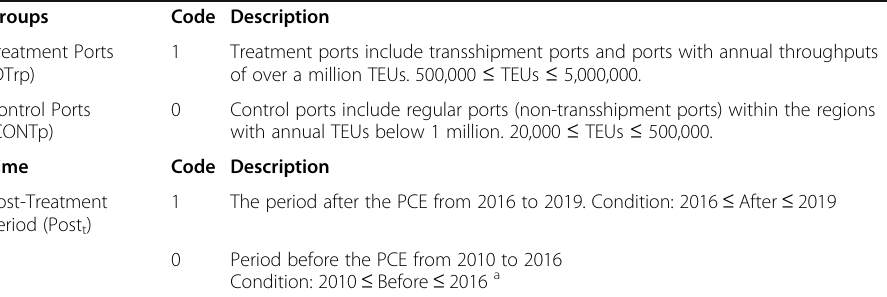
Table 3 Classification of Treatment and Control Groups (100 Ports) within LAC